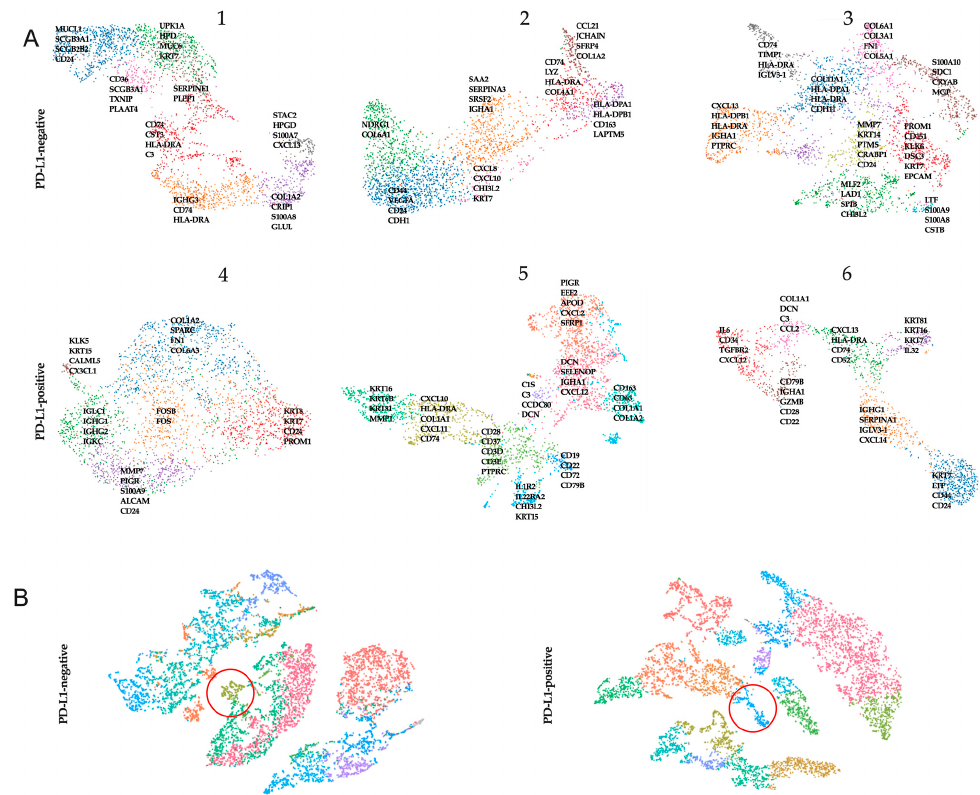
Figure 2. UMAP clustering of tumor samples with the indicated genes of the leading edge of the signature in each cluster in PD-L1-negative and PD-L1-positive patients ( A ). The key genes characteristic of each of the clusters (represented as clouds of dots of different colors) within a single patient (1–6) are presented. Similar cell cluster among PD-L1-negative tumor samples and PD-L1-positive tumor samples ( B ) from merged data, the red circle indicates the similar cell cluster in all patients.